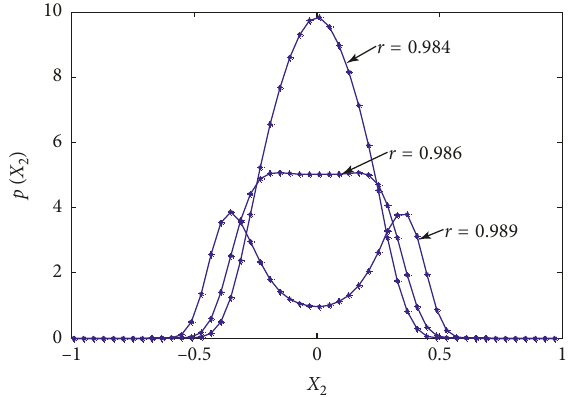
� 0 . 05 for different r . 1